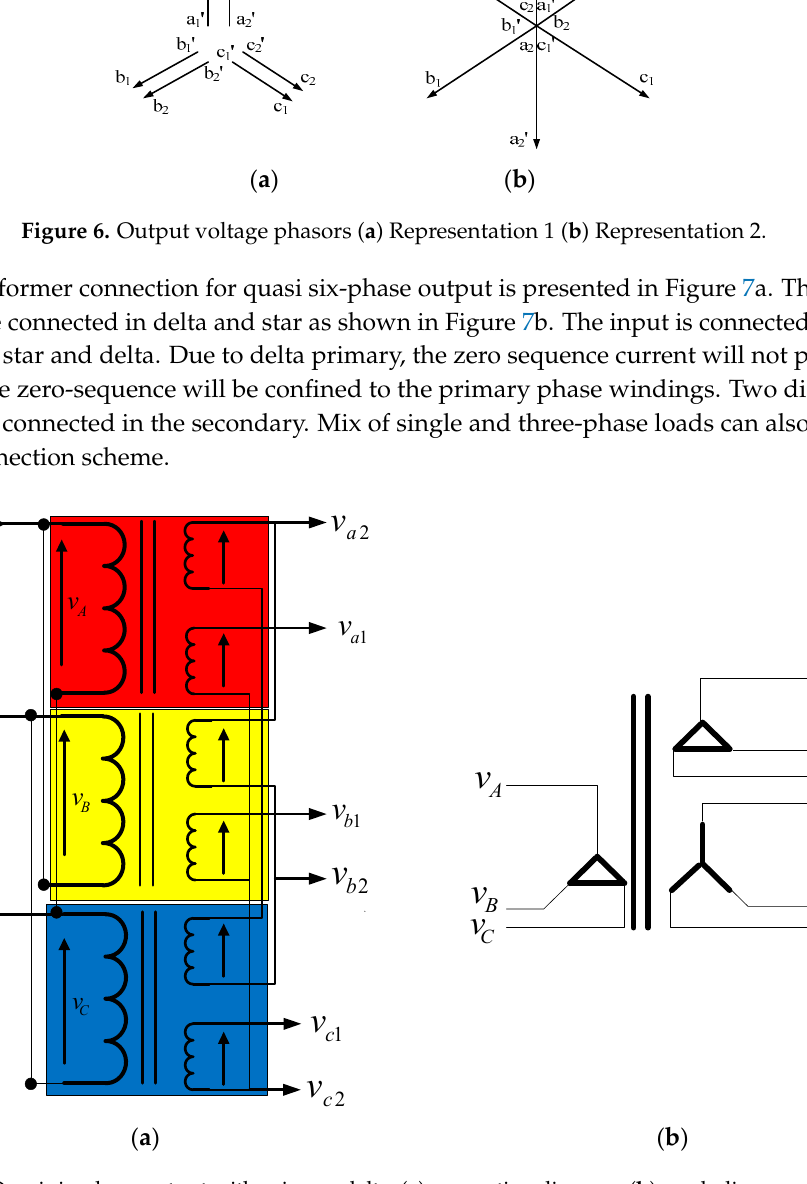
( b ) Figure 5. Six-phase output with primary delta; ( a ) connection diagram; ( b ) symbolic representation. The symbolic representation of this connection scheme is illustrated in Figure 4b. The star point at the input is formed by connecting one terminal of each transformer. The star point at the secondary is formed by connecting the mid-point of the secondary windings. Each half winding of the secondary produces 180 degree displaced voltages. Hence phase ‘a’ and ‘d’ is obtained from first transformer (two opposing output phases). Similarly, output phase ‘c’ and ‘f’ is obtained from second transformer and output phase ‘e’ and ‘b’ is formed from third transformer (refer to Figure 4a). The magnitude of the output voltage is decided by the turn ratio of the transformer. This is further understood from the phasor diagram given in Figure 5. The connection at the primary can also be delta as shown in Figure 5. The connection of primary windings is shown in Figure 5a and the symbolic representation is given